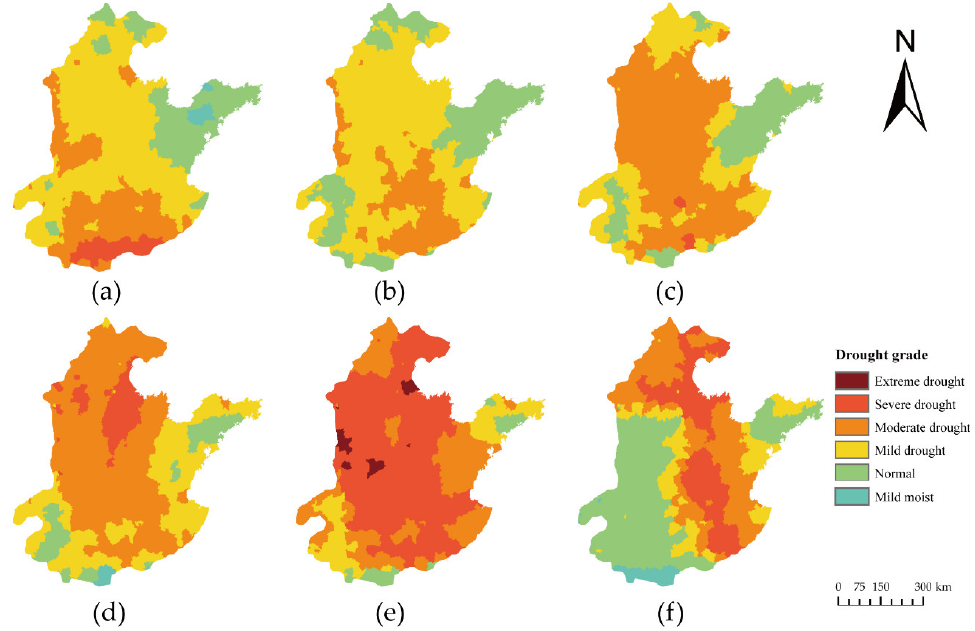
Figure 8. The degree of drought in the HHHP: ( a ) autumn 2001; ( b ) winter 2001; ( c ) spring 2002; ( d ) summer 2002; ( e ) autumn 2002; and ( f ) winter